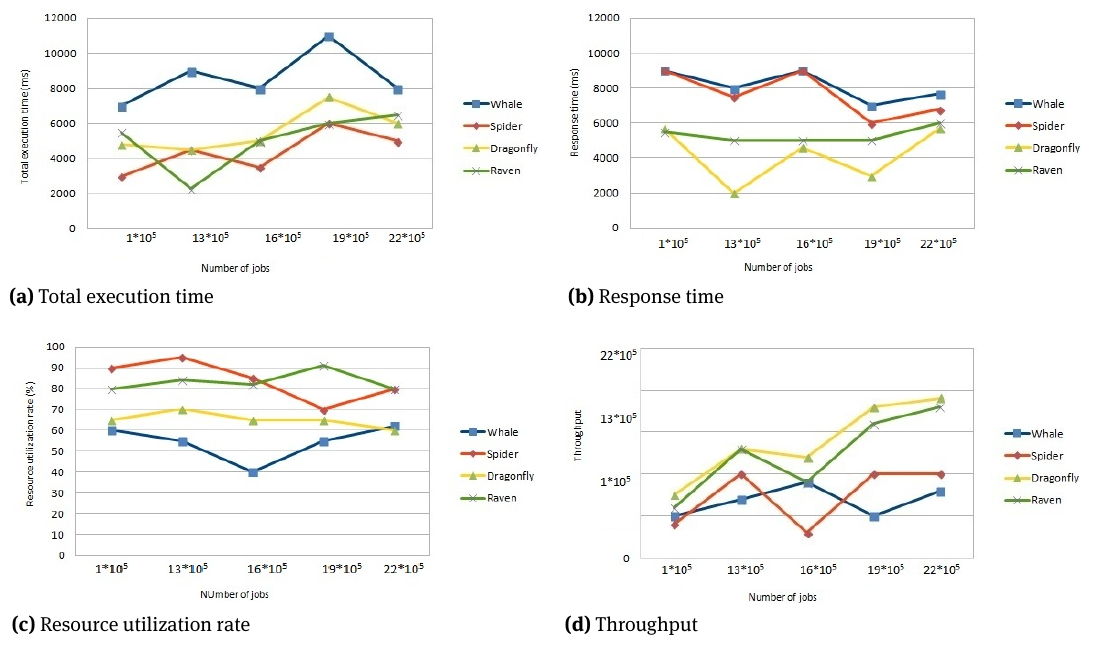
Figure 7: Performance under